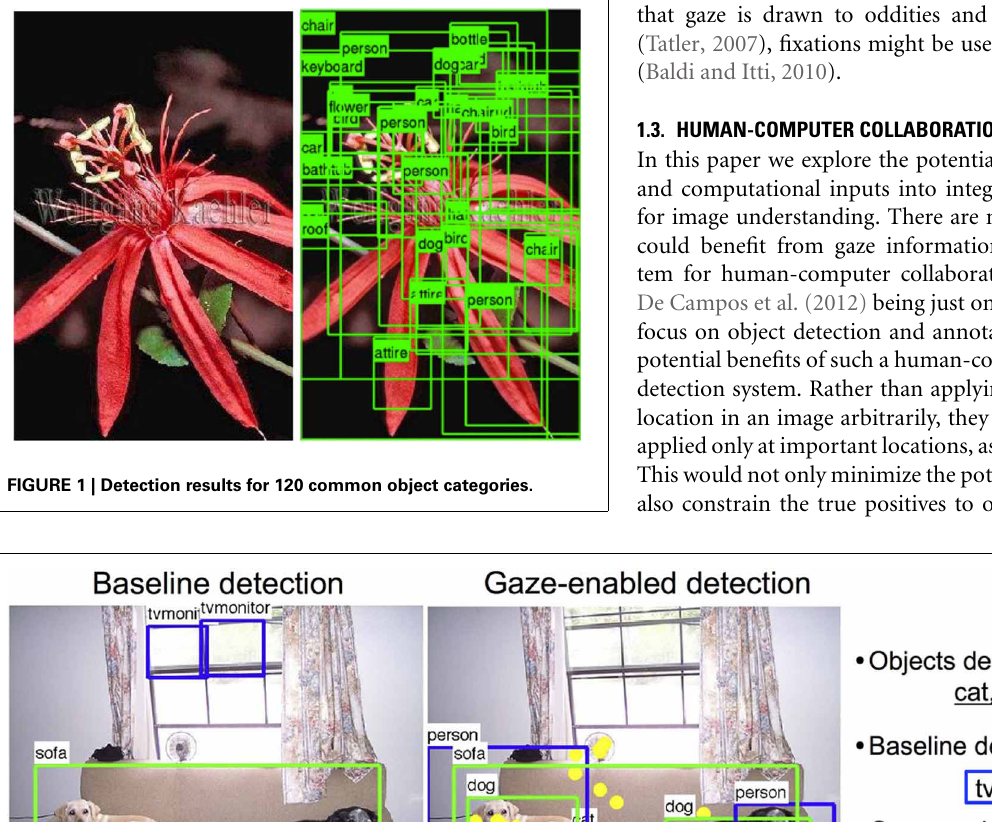
Middle: Gaze-enabled detection results with fixations (yellow). Right: Objects described by people and detected objects from each method (green - correct, blue -